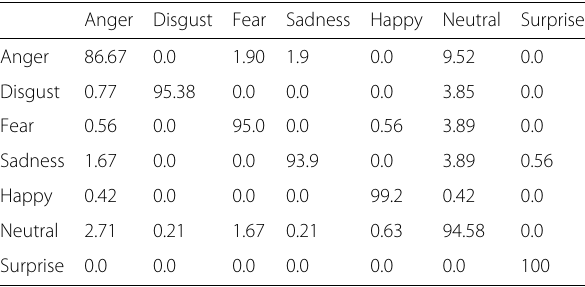
expression recognition on CK